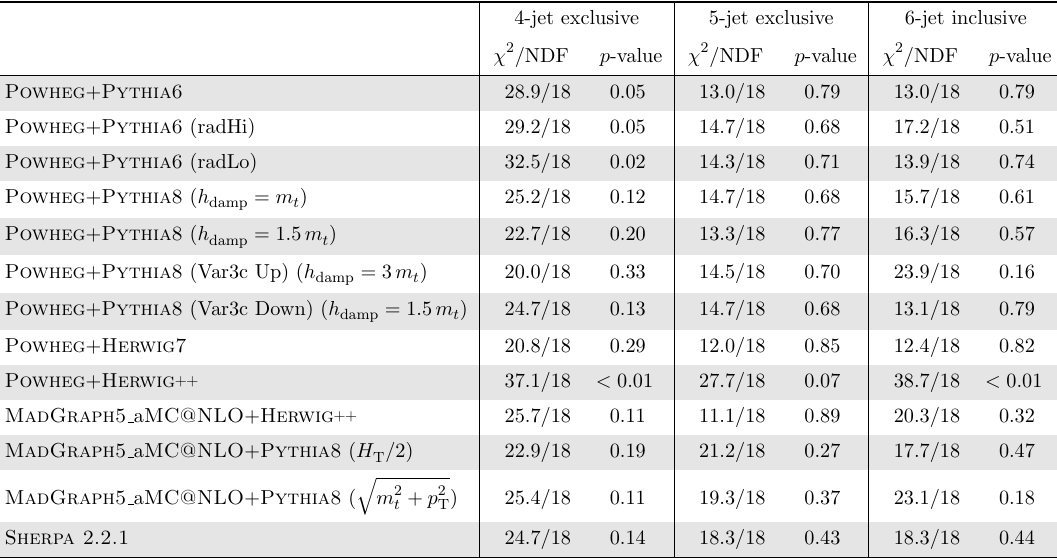
Table 3 . Comparison of the measured (cid:12)ducial phase space absolute di(cid:11)erential cross sections as a function of p t; had T measured spectrum. The number of degrees of freedom (NDF) is equal to the number of bins in the